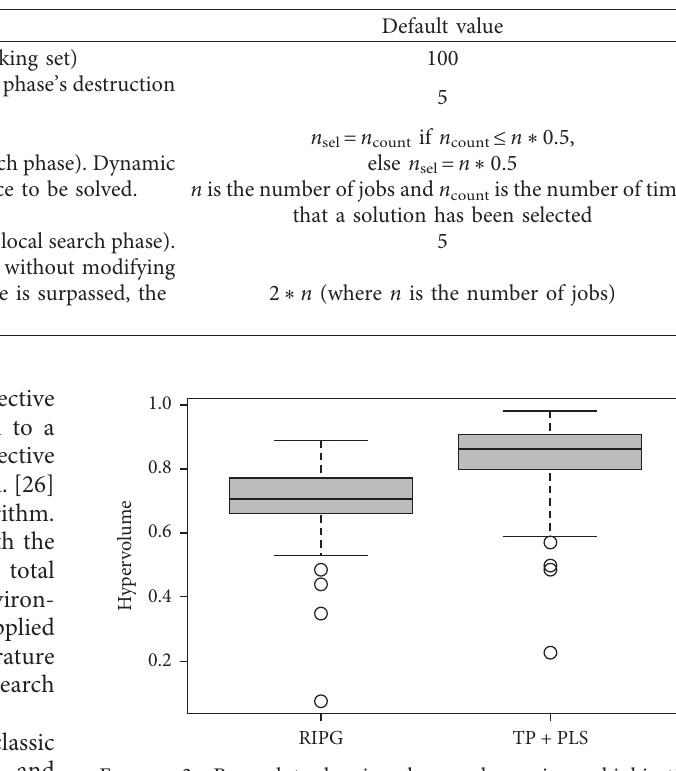
Table 1: Classical parametrization for the RIPG algorithm.